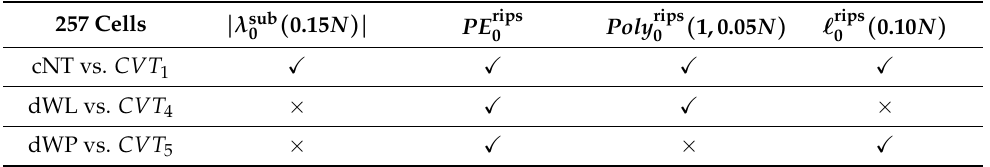
Figure 6. An example of images of epithelial tissues ( top row ), their CVT-path counterpart ( middle row ), and a histogram with their polygonal distribution ( bottom row ). In the first column, we show cNT and CVT 1 ; in the second, dWL and CVT 4 , and in the third, dWP and CVT 5 . Table 4. Differences between some tissues and their CVT-path counterpart. A check mark implies that the p -value of that variable is smaller than 0.01 in the Mann–Whitney U test and a cross mark that we could not find significant differences using that